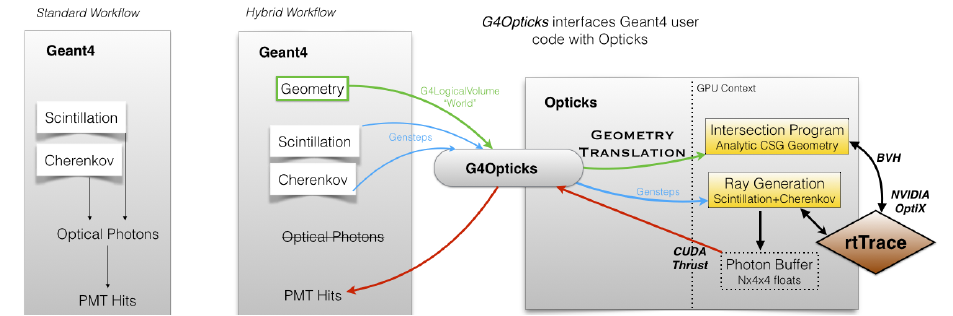
Figure 2. Comparison of the standard workflow of Geant4 optical photon simulation (left) with the hybrid Geant4 + Opticks workflow (right). A single Opticks class G4Opticks acts to interface Geant4 user code with the Opticks GPU propagation. Hybrid simulation requires modification of the classes representing scintillation and Cherenkov processes to collect "genstep" data